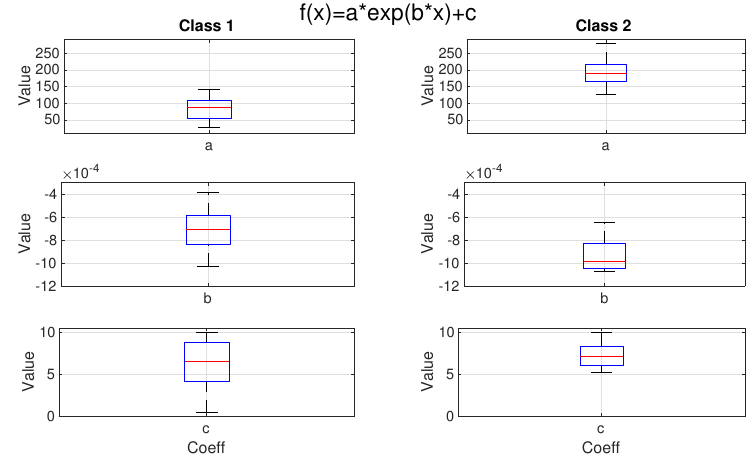
Figure 16. Boxplots of parameters of the fitted exponential functions (11)